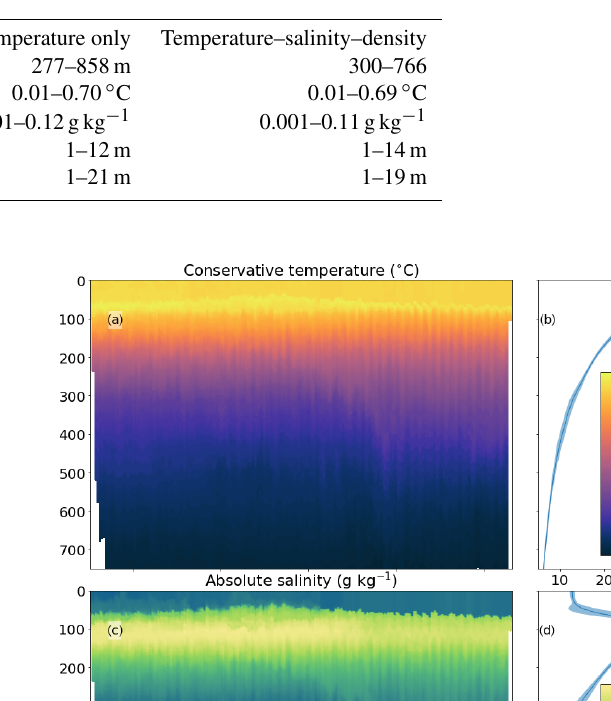
Figure 7. Mean thermohaline staircase mixed layer thickness ob- served by SG620 (stars) and SG637 (circles) coloured by the total thickness of the identified staircase mixed layers summed over the whole profile. Glider data from the tropical North Atlantic.